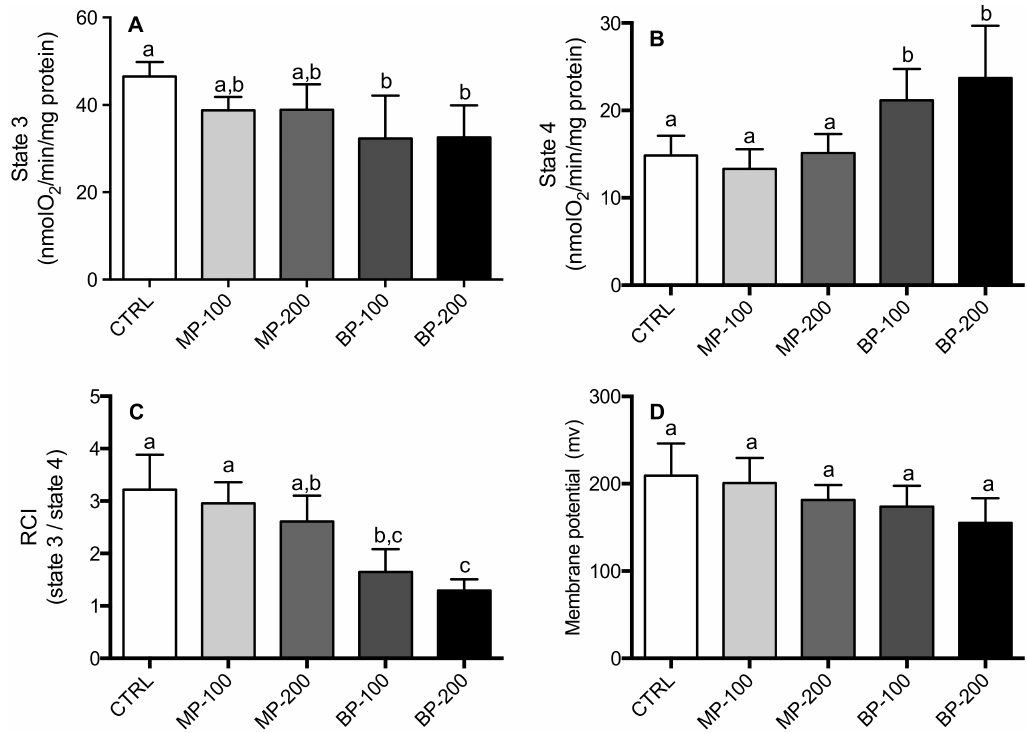
Figure 2. Oxygen consumption rates determined with mitochondria isolated from testicles of F1 generation rats. The parameters presented are respiratory state 3 ( A ), state 4 ( B ), respiratory control index (RCI) ( C ), and transmembrane potential ( D ). Mitochondria (0.8 mg / mL) were incubated at 30 ◦ C in 1 mL of normal respiratory medium supplemented with rotenone (1.5 µ g / mL). State 3 was obtained by the addition of 200 nmol of ADP in mitochondria to oxidize succinate (10 mM). State 4 was reached after total phosphorylation of ADP. The RCI was calculated as the ratio between the oxygen consumption rate in state 3 and state 4. Succinate-energized mitochondria ∆Ψ was measured by means of a tetraphenylphosphonium-selective electrode. Freshly isolated mitochondria (1 mg) were incubated in 1 mL of the medium supplemented with 2 µ M rotenone and 3 µ M TPP + and energized with 5 mM succinate. Results are expressed as nmol of oxygen consumed / min / mg of mitochondrial protein and are M ± SD of 7–10 independent experiments performed in duplicate. The values marked with the same letter are not statistically significant as determined by the Tukey’s post hoc test ( p < 0.05).